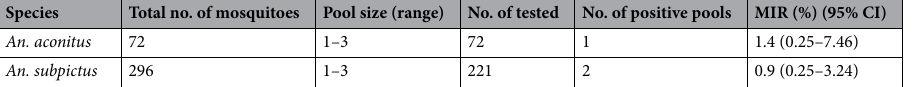
Table 2. Minimum infection rates (MIR) of P. caprae among collected